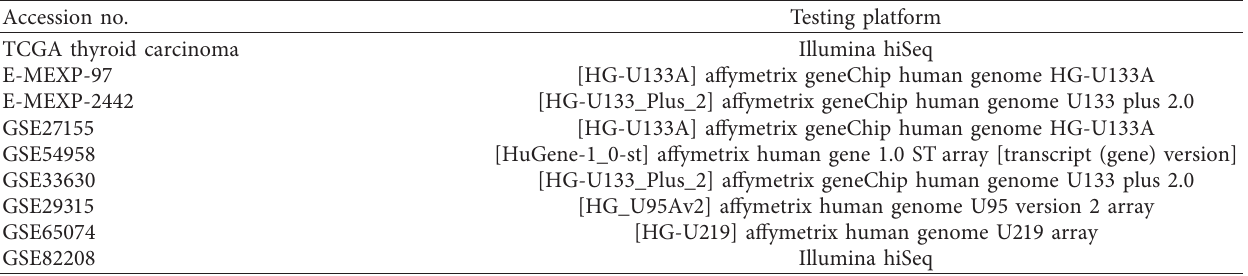
Table 1: Testing platforms of the datasets used in this study.